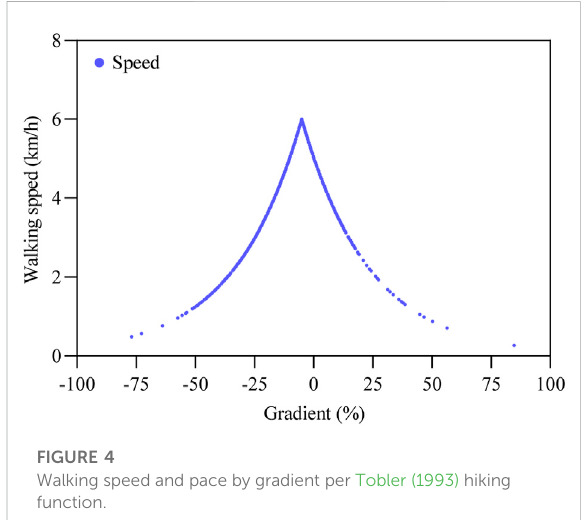
FIGURE 4 Walking speed and pace by gradient per Tobler (1993) hiking function.